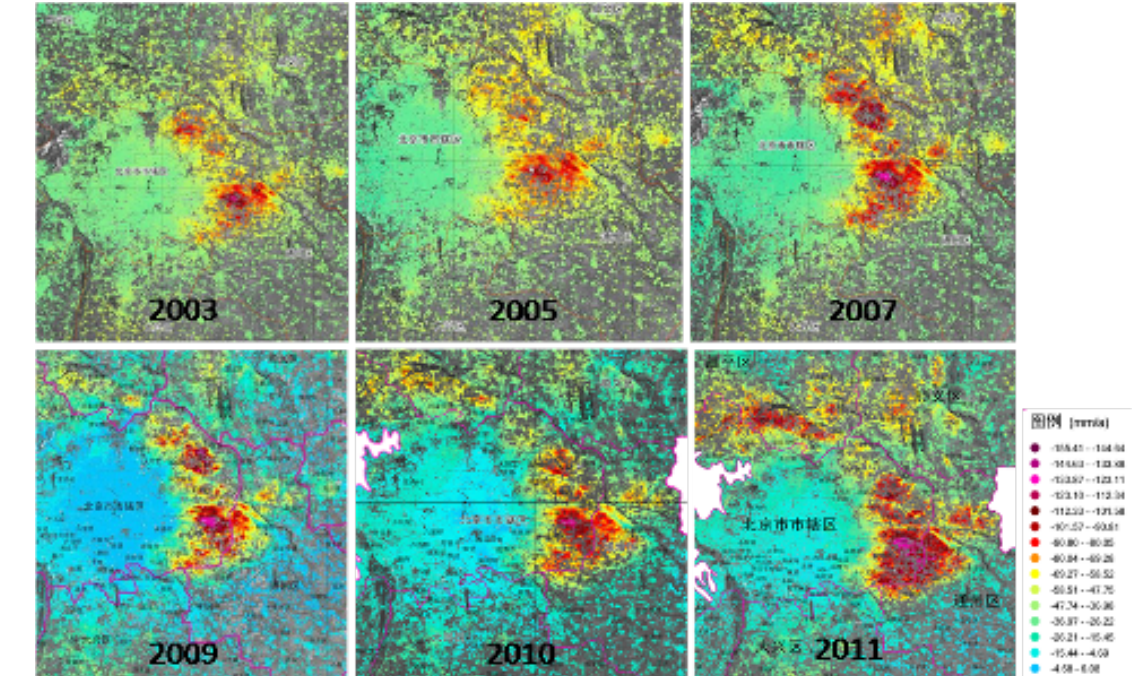
Figure 4. Land subsidence mapped using PSI technique